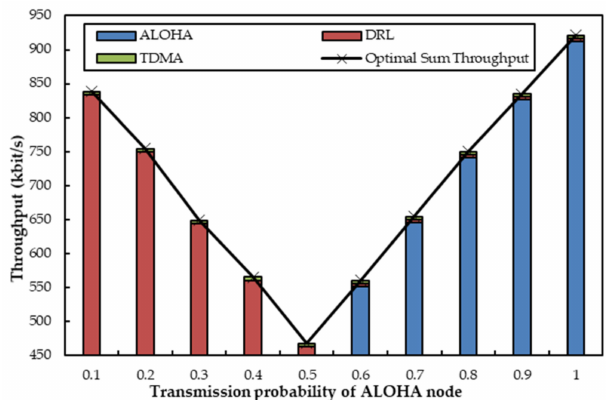
Figure 5. Sum throughput when one agent coexists with one optical ALOHA node and one acoustic TDMA node, which have fixed R and variable q ,